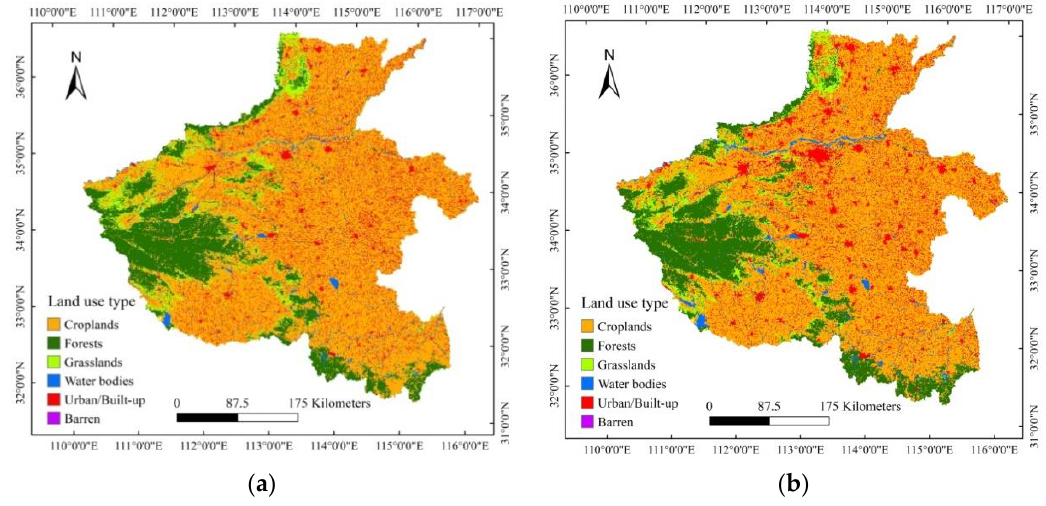
Figure 11. Land-use types of Henan province after reclassification in 2000 ( a ) and 2020 ( b ).